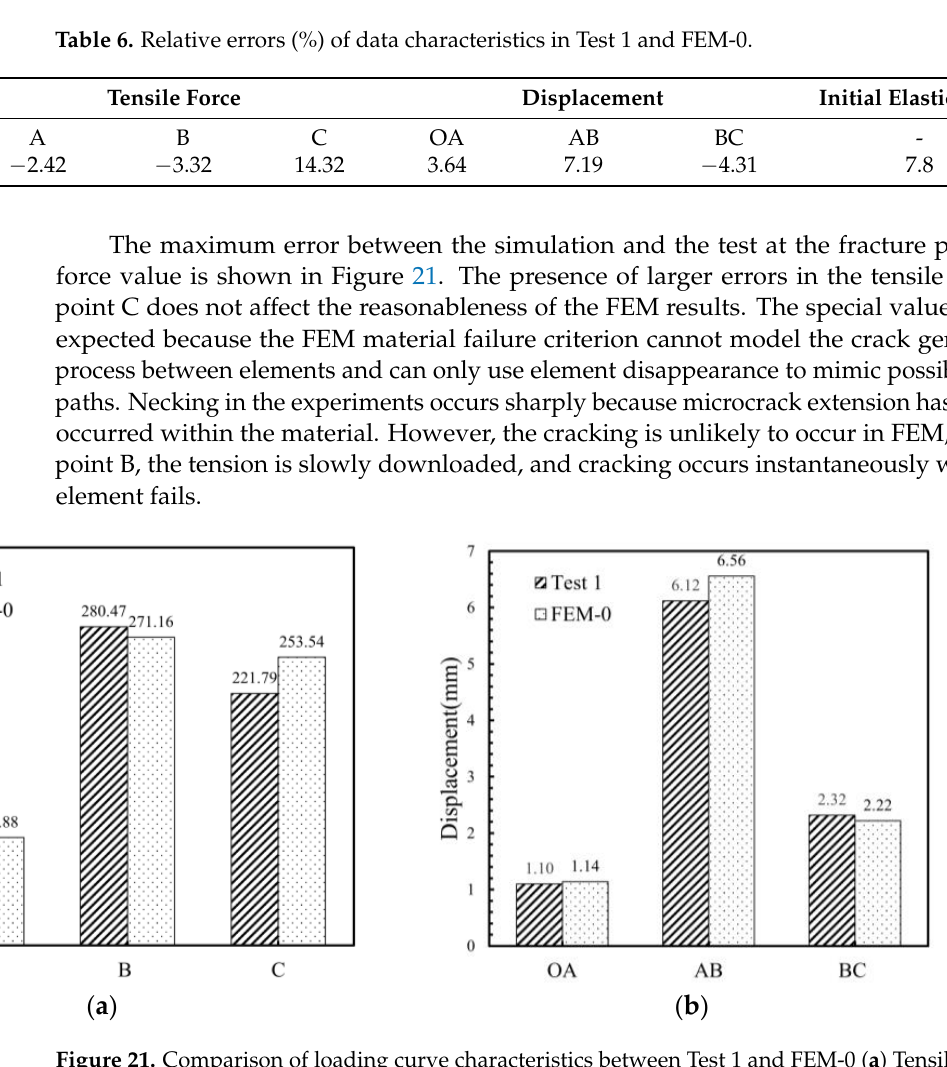
Figure 21. Comparison of loading curve characteristics between Test 1 and FEM-0 ( a ) Tensile force at the three transition nodes, ( b ) Deformation of the three tensile phases.